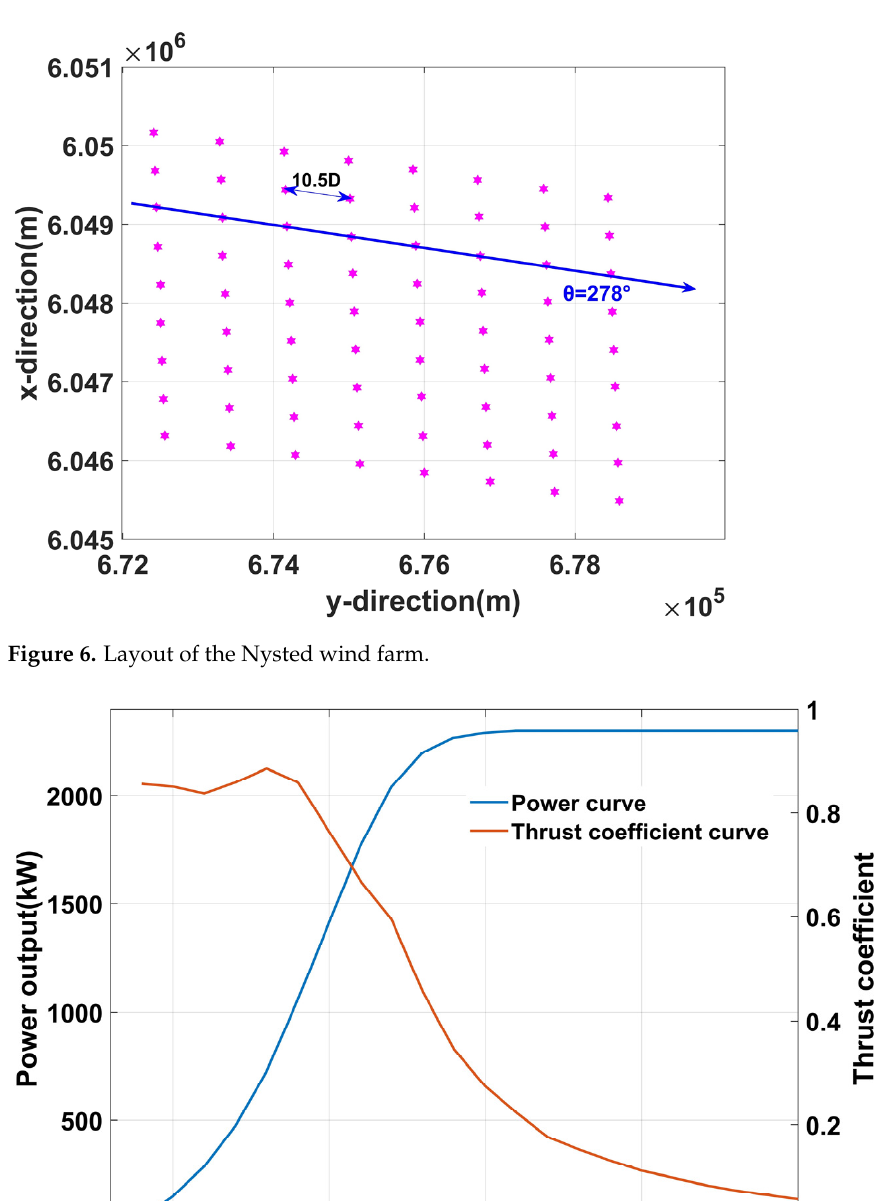
8 of 24 Figure 5. Power curve and thrust coefficient curve from Vestas V80 2 MW. 3.2. Nysted Offshore Wind Farm Case The Nysted offshore wind farm is a Danish offshore wind farm. It is located in the Baltic Sea, north of the German coastline and 10 km from the coastline of the island of Lolland in southeastern Denmark. It was built in 2003 and has a total installed capacity of 165.6 MW, consisting of 72 Bonus 2.3 MW wind turbines manufactured by Siemens Wind Power. The 72 wind turbines are arranged in a parallelogram grid with nine rows and eight columns, as shown in Figure 6. Each turbine is a Bonus 2.3 MW wind turbine, with the diameter of 82.4 m and a height of 68.8 m. The data of power and thrust coefficient are from reference [33], thus the power curve and thrust coefficient curve of the Bonus 2.3 MW wind turbine can be shown in Figure 7.